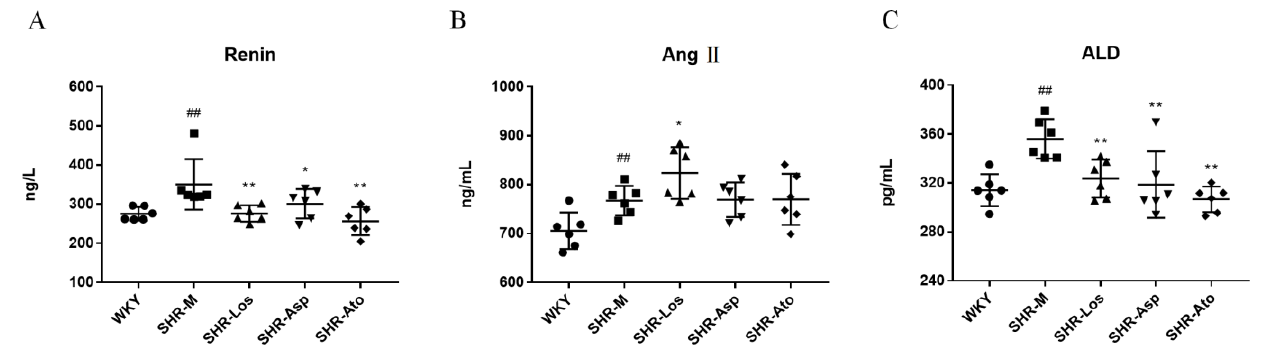
Figure 6. Effects of losartan, aspirin, and atorvastatin on the plasma contents of renin( A ), Ang II( B ),